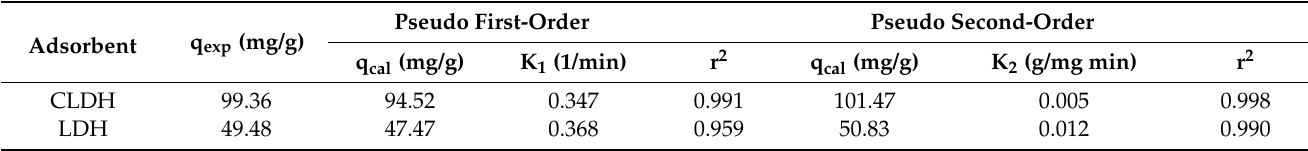
Figure 6. Adsorption kinetics of PBV by ( a ) CLDH and ( b ) LDH: C 0 = 15 mg/L, R = 0.1 g/L, initial pH = 5.52 and T = 25 °C. Table 3. Kinetics models constants for PBV adsorption by CLDH and